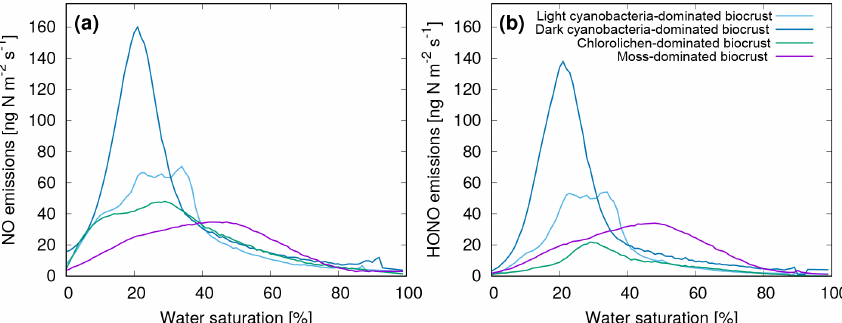
Figure 1. Average emissions of (a) NO and (b) HONO as a function of water saturation of four different biocrust types. The emissions were measured on biocrust samples in the laboratory at 25 ◦ C. See Weber et al. (2015) for further